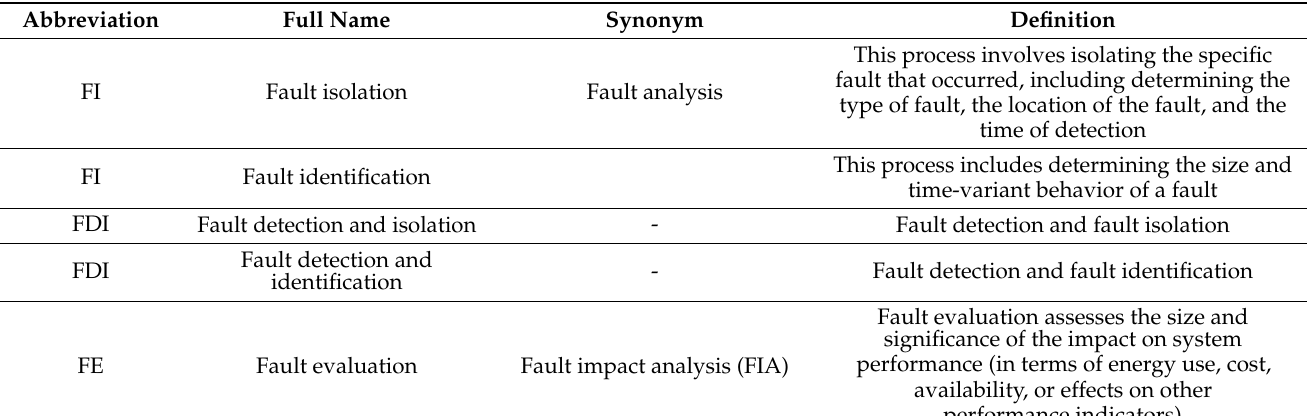
Table 3. Nomenclature of subprocesses for FDD in building systems.